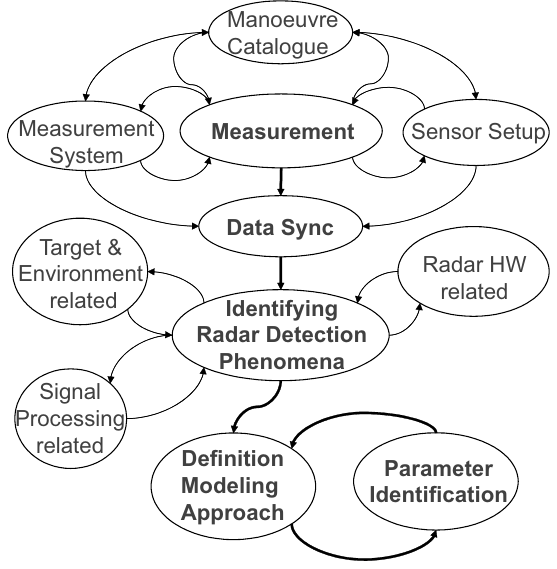
Figure 1. Process flow to derive the radar sensor